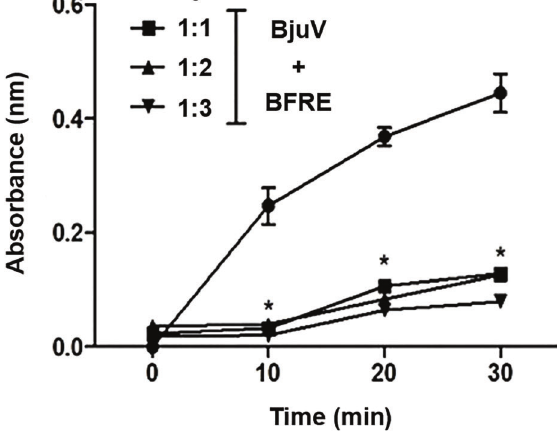
Figure 2. Effect of Bredemeyera fl oribunda root extract (BFRE) on the proteolytic activity of Bothrops jararacussu venom (BjuV). BFRE was preincubated with BjuV at ratios of 1:1, 1:2, and 1:3 (BjuV:BFRE). DL-BApNA was used as a substrate and increas- ing absorbance was measured at 410 nm. Data are reported as means ± SE. *P o 0.05, ***P o 0.001 compared to BjuV; # P o 0.05 compared among BFRE 1:1 ratio (ANOVA with Bonferroni